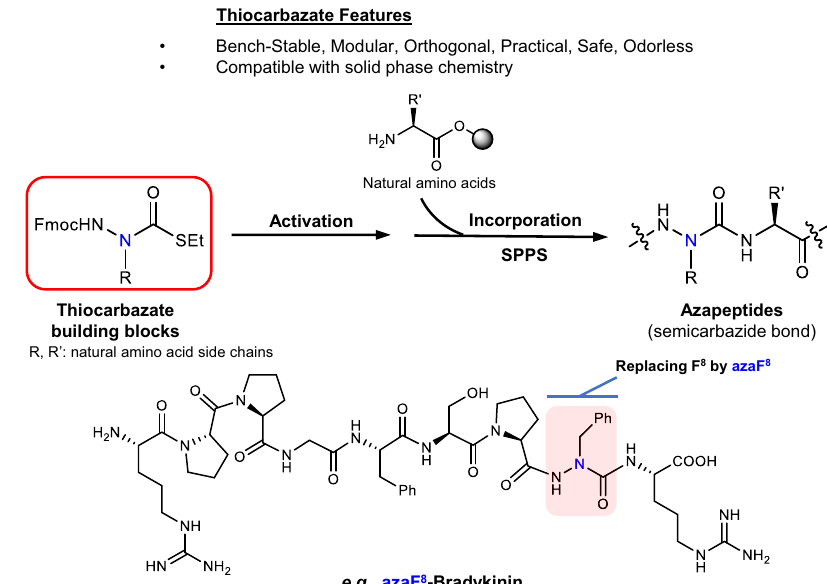
Fig. 1 | Overview of thiocarbazate-directed azapeptide synthesis platform and applications. Thiocarbazate building blocks can be incorporated into a peptide sequence using solid-phase peptide synthesis (SPPS) in a rapid and practical